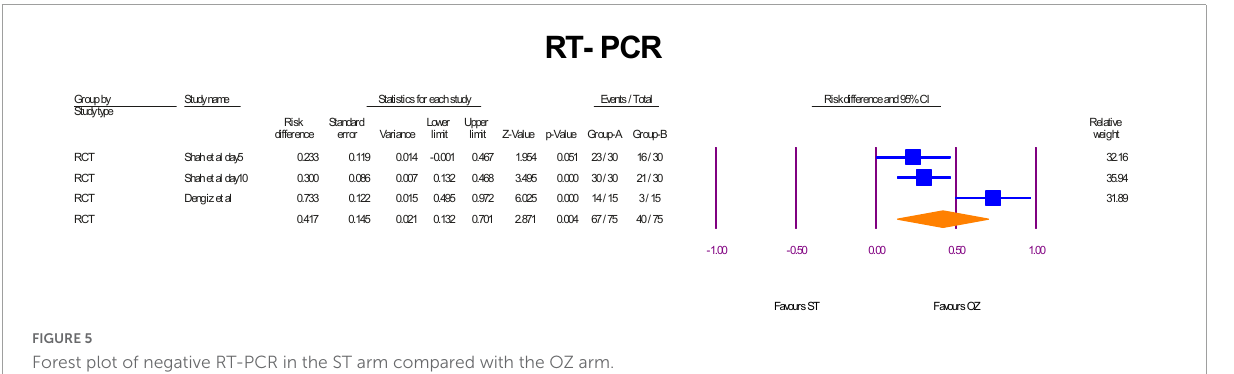
FIGURE5 Forest plot of negative RT-PCR in the ST arm compared with the OZ arm.